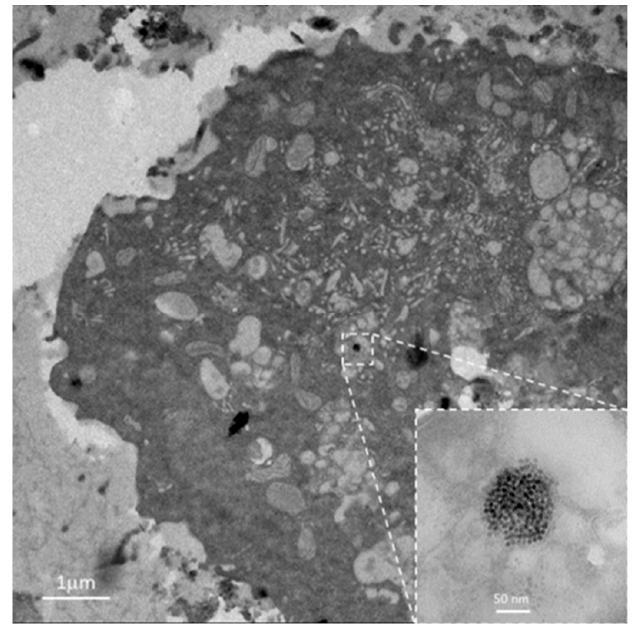
Figure 4. TEM thin section micrographs of fixed and embedded Npc1-deficient CHO exposed to CySPION supporting nanoparticles’ cellular internalization.